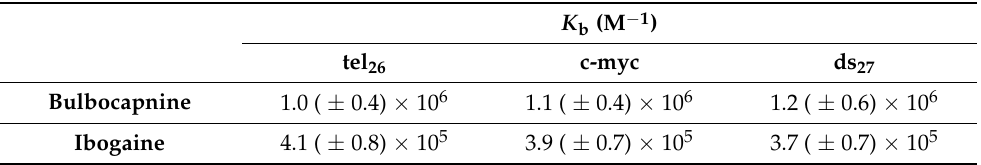
Table 3. Binding constants ( K b ) obtained by fitting of fluorescence data for DNA/Bulbocapnine and DNA/Ibogaine systems by using an independent and equivalent-sites model